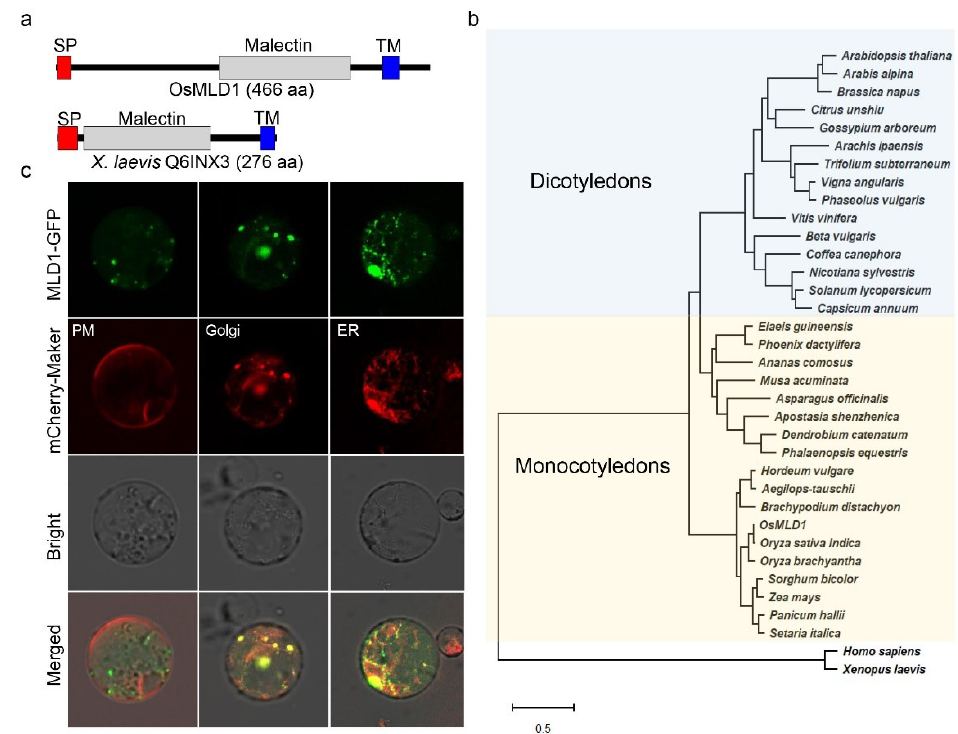
Figure 2. OsMLD1 is an ER- and Golgi-associated protein. ( a ) Schematic representation of OsMLD1 and its homolog from Xenopus laevis (Q6INX3). SP indicates signal peptide; TM indicates the trans- membrane domain. ( b ) Phylogenetic tree of OsMLD1 and its homologs from other plant species. Oryza sativa Geng, OsMLD1; Oryza sativa Indica, EAY88339.1; Oryza brachyantha , XP_006650992.1;